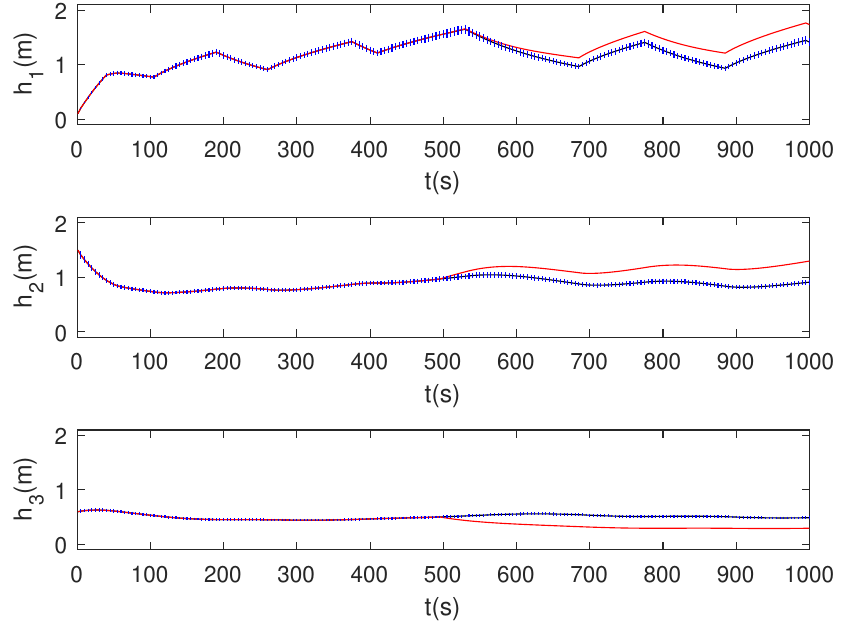
Figure 7. Faulty three-tank system: clogging between tanks 2 and 3 from t = 500 s. Blue bands represent the computation using marks while red lines correspond to the measured values of the three state variables.